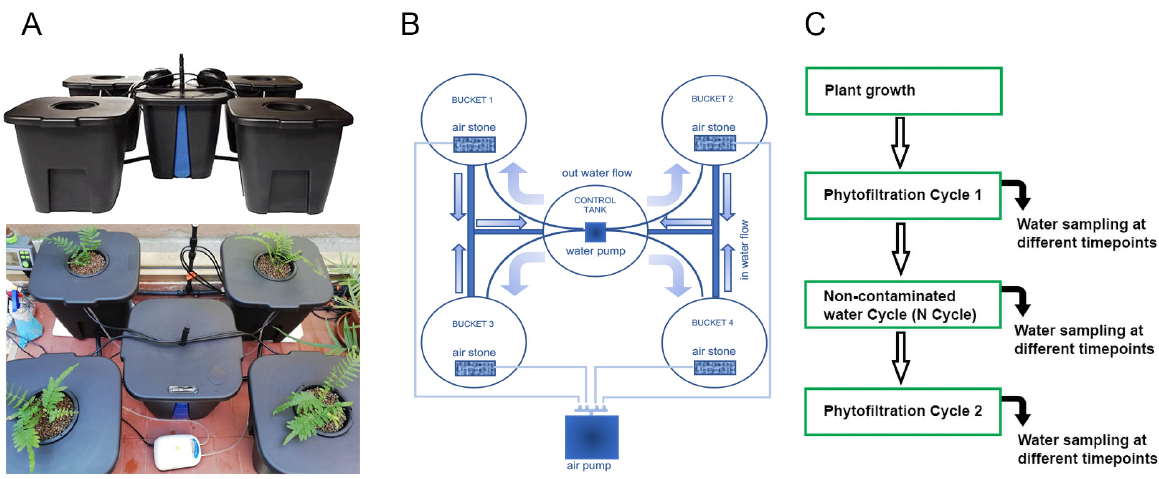
Figure 3. Recirculating Deep Water Culture (RDWC). ( A ) RDWC system used for sporophytes growth, showing a central control tank connected to 4 DWC buckets. ( B ) Functionl Scheme of the RDWC, indicating the components of the system and the outward water flow and inward water flow, respectively from and to the control tank. ( C ) Schematic workflow of phytofiltration experiments, performed under environmental controlled conditions, using As contaminated water collected from Varano waterwell. out water flow: outward water flow, in water flow: inward water flow.